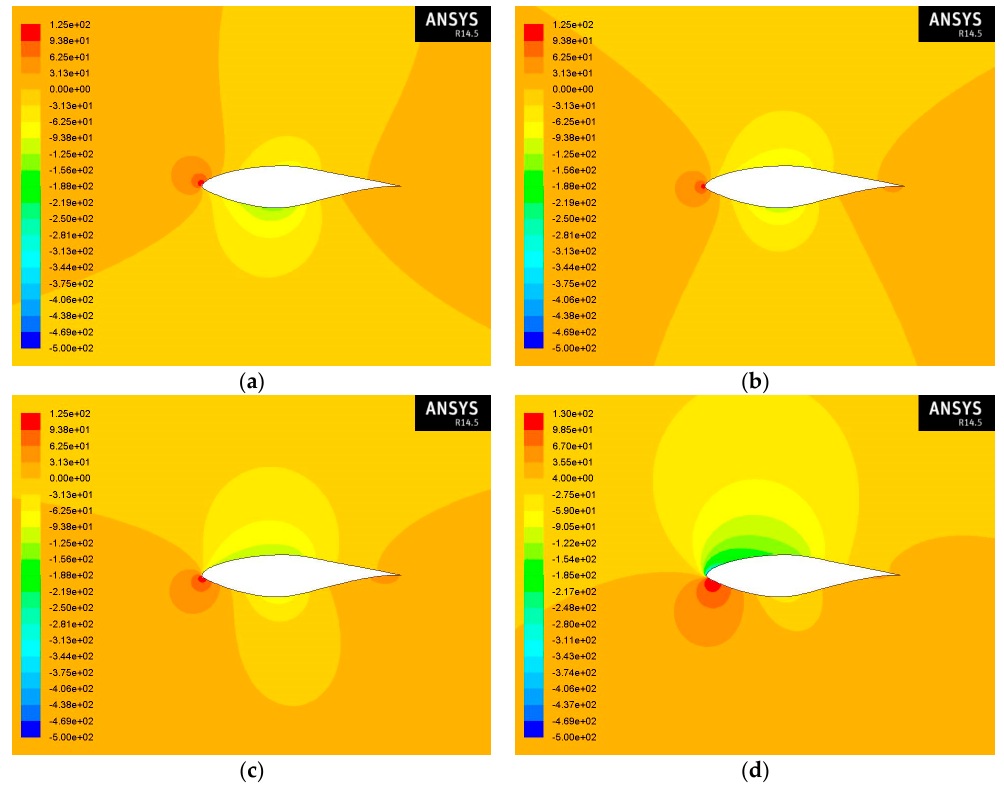
Figure 7. Contours of static pressure at ( a ) − 3°; ( b ) 0°; ( c ) 3°; and ( d ) 9° angles of attack at Re = 1 × 10 6